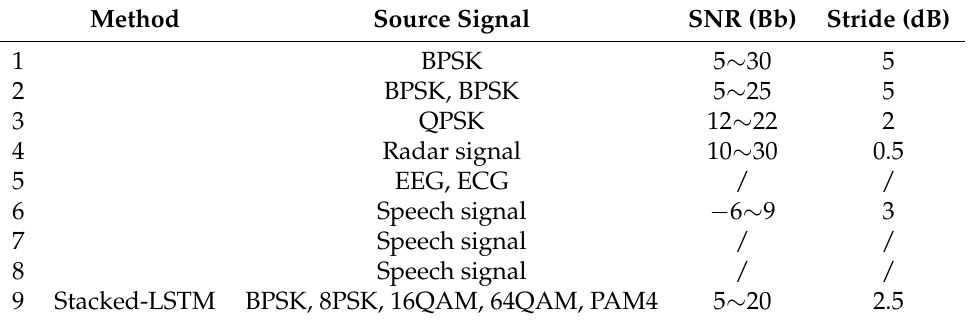
Table 1. Single-channel BSS algorithms.